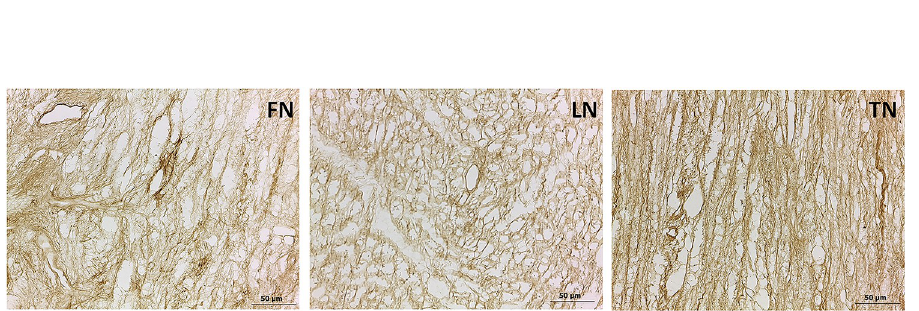
Fig 5. Evaluation by immunohistochemistry of structural protein retention in d-ECM. Representative images of fibronectin (FN), laminin (LN) and tenascin (TN) distribution in cardiac d-ECM. Scale bar length is 50 μ m.